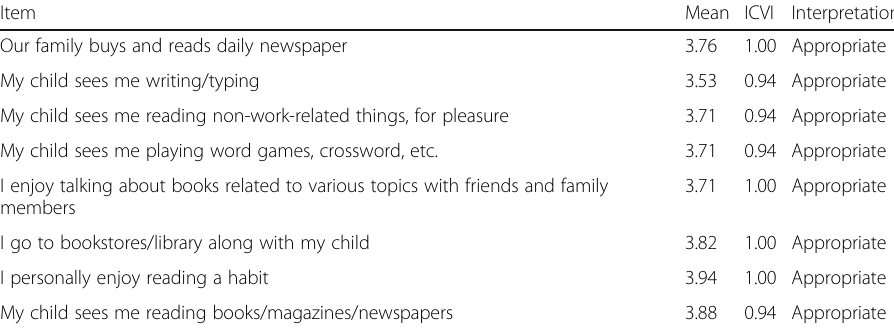
Table 1 Item Level Content Validity Index (ICVI) for the dimension “ Physical environment ” (PE) Item Mean ICVI Interpretation